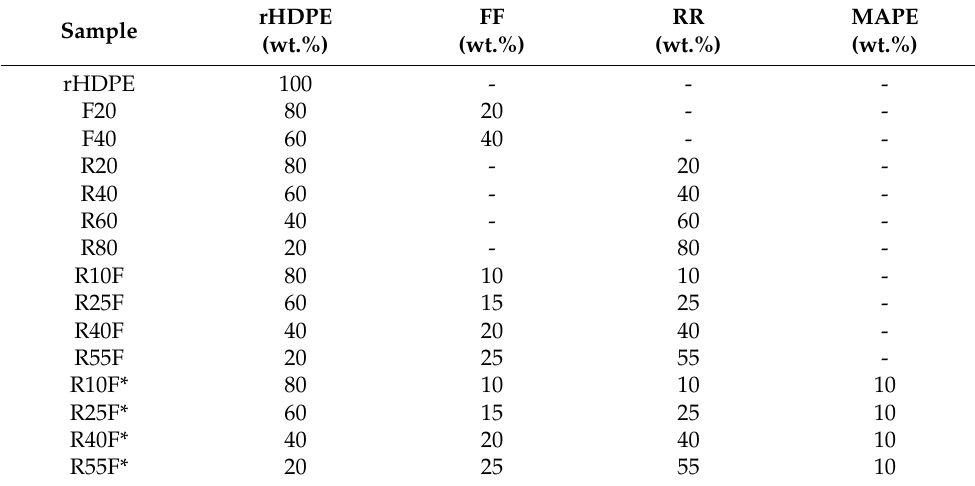
Table 1. Compositions investigated with their